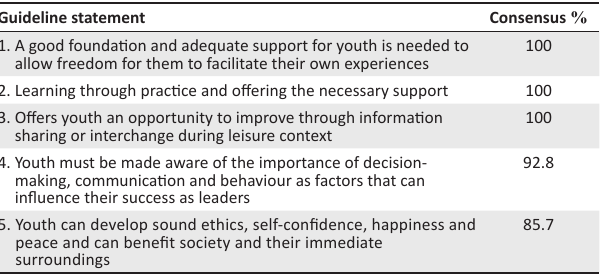
TABLE 6: Guidelines of the implications for allowing youth to take the lead in facilitating their leisure activities.